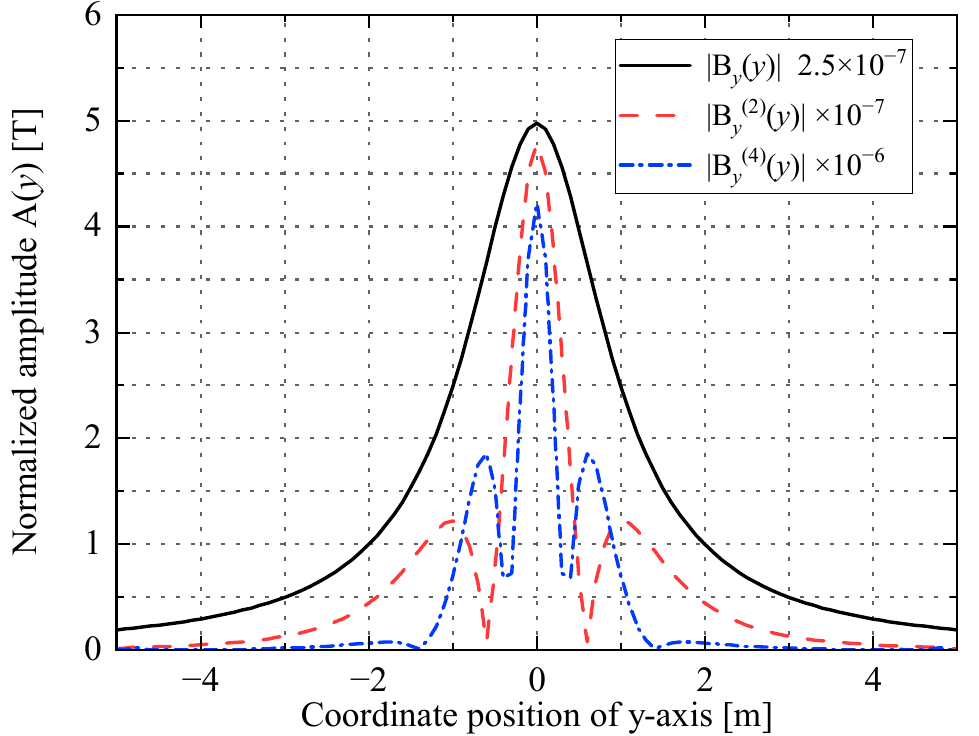
Figure 2. Curves of three shape functions.